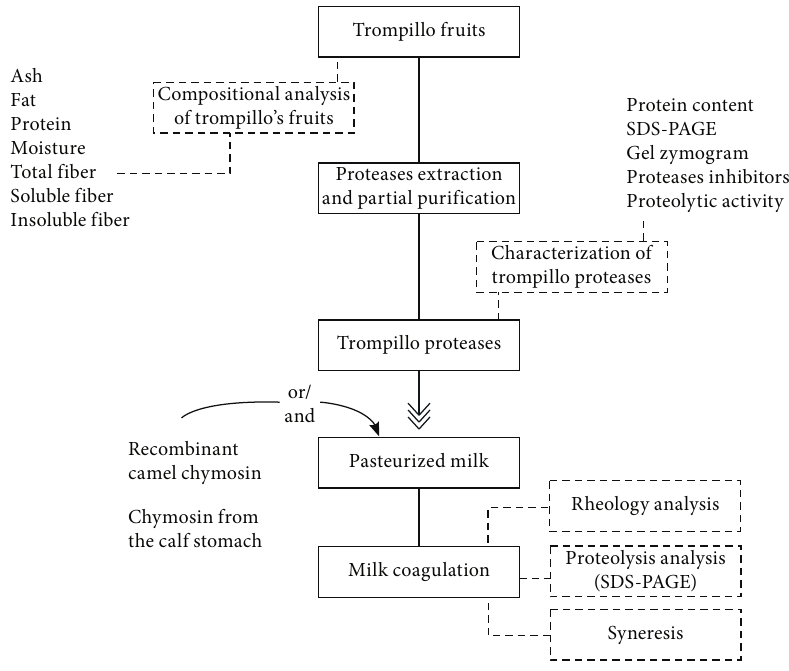
Figure 1: Schematic diagram of the methodology used in this